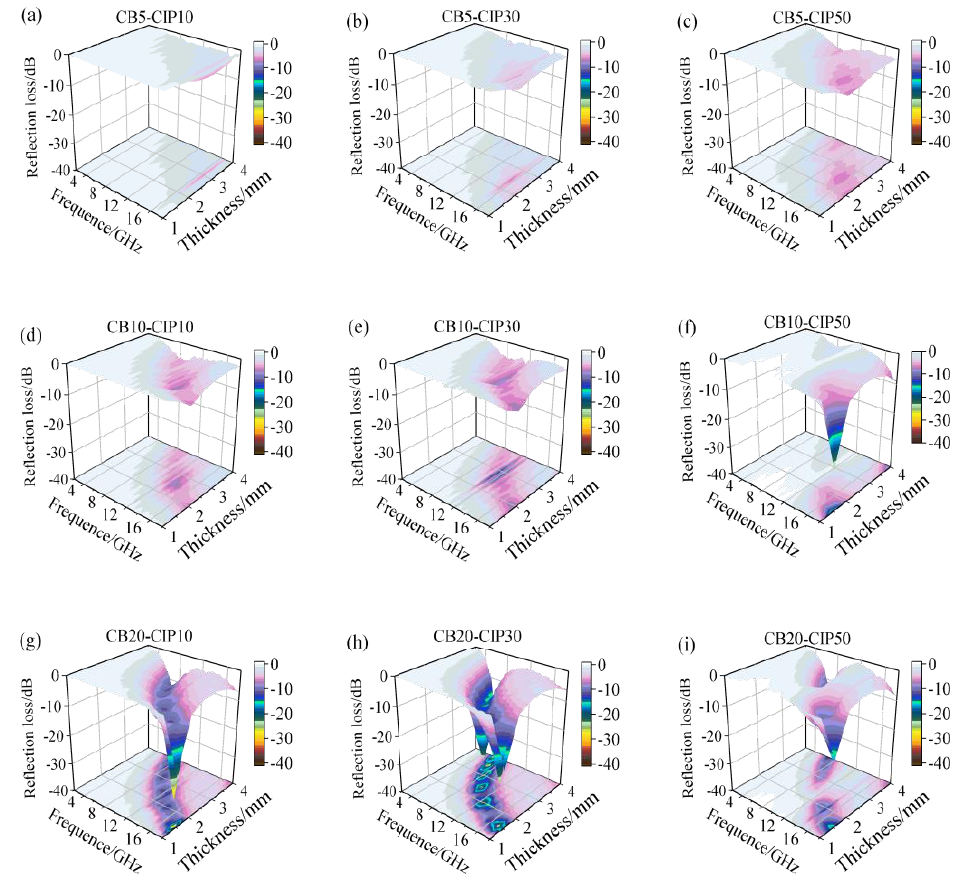
Figure 5. Three − dimensional diagrams of RL of the composites with different compositions: ( a ) CB5 −− CIP10; ( b ) CB5 −− CIP30; ( c ) CB5 −− CIP50; ( d ) CB10 −− CIP10; ( e ) CB10 −− CIP30; ( f ) CB10 −− CIP50; ( g ) CB20 −− CIP10; ( h ) CB20 −− CIP30; ( i ) CB20 −− CIP50.